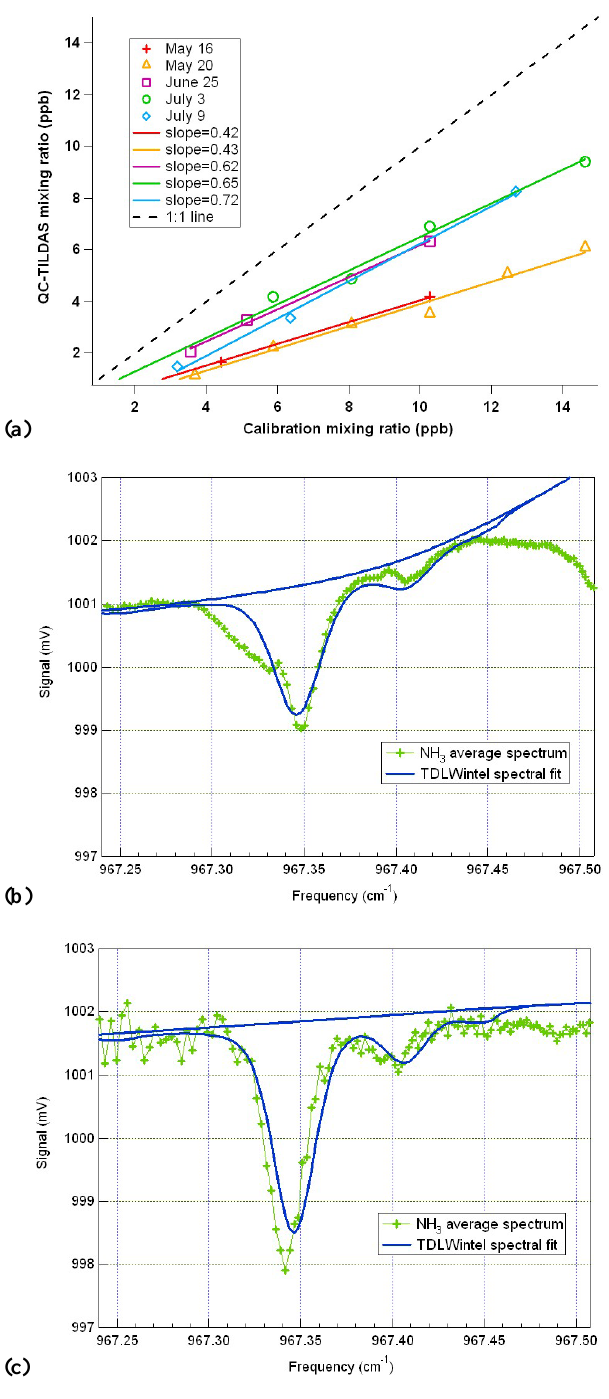
Fig. 1. Multiple point calibrations (a) performed throughout the two month field study indicate QC-TILDAS is underestimating NH 3 . Spectra retrieved at high laser output power (b) exhibit considerable laser line shape distortion resulting in calibration slope of ∼ 0.42 and spectra exhibiting little distortion but increased noise (c) at low laser output power result in an average calibration slope of 0.66.